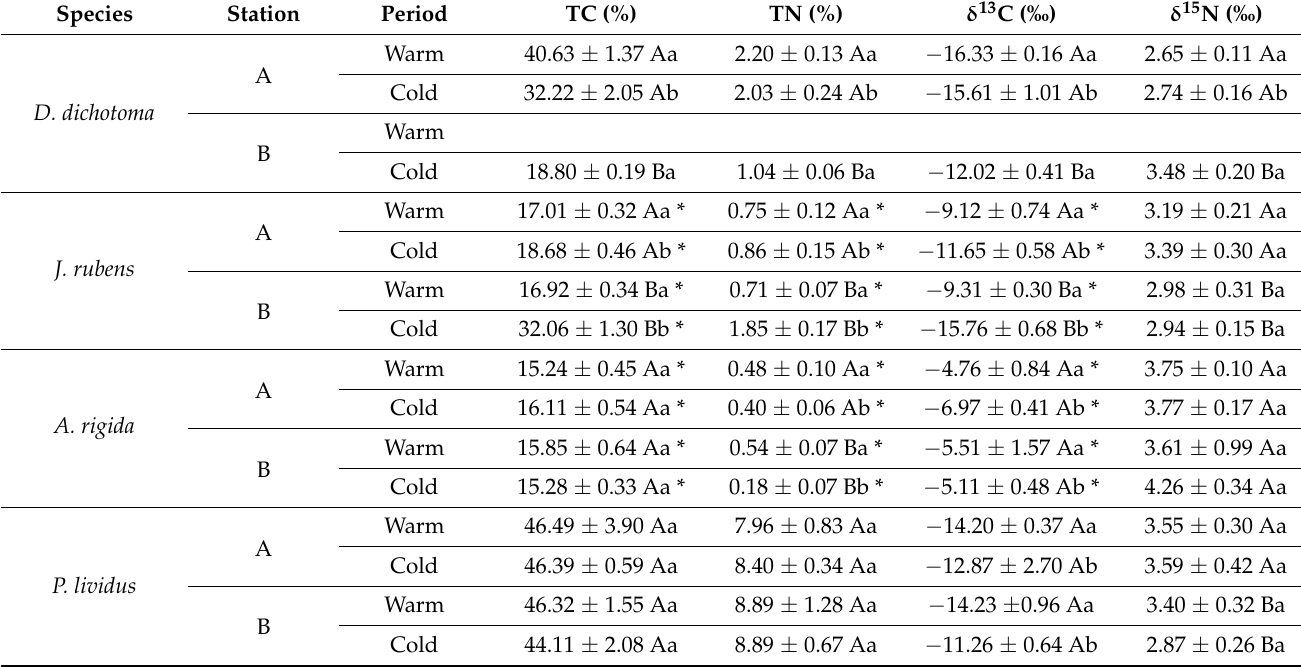
Table 4. Average values of physiological variables for P. lividus, D. dichotoma, J. rubens, and A. rigida for the two stations in the cold and warm periods. Values are X ± SE ( n = 5). The significant differences ( p ≤ 0.05) between stations are represented by capital letters and between seasons by small letters. * Indicates the interaction effect between station and